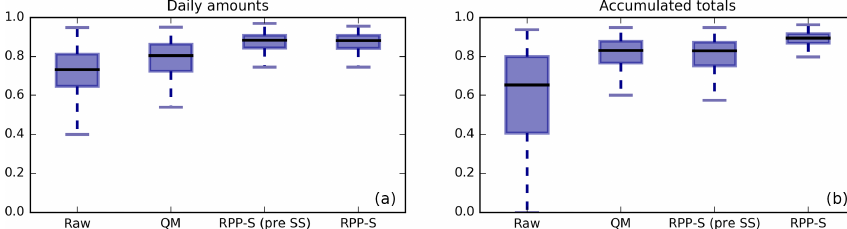
Figure 5. α -index of reliability for forecast daily rainfall amounts (a) and forecast accumulated rainfall totals (b) . Results for four types of forecasts are presented: raw, QM, RPP-S before Schaake Shuffle (pre SS) and RPP-S forecasts after the Schaake Shuffle. Higher α -index indicates better reliability. The box plots display the median as a black line. The box spans the interquartile range and the whiskers span the [0.1, 0.9] quantile